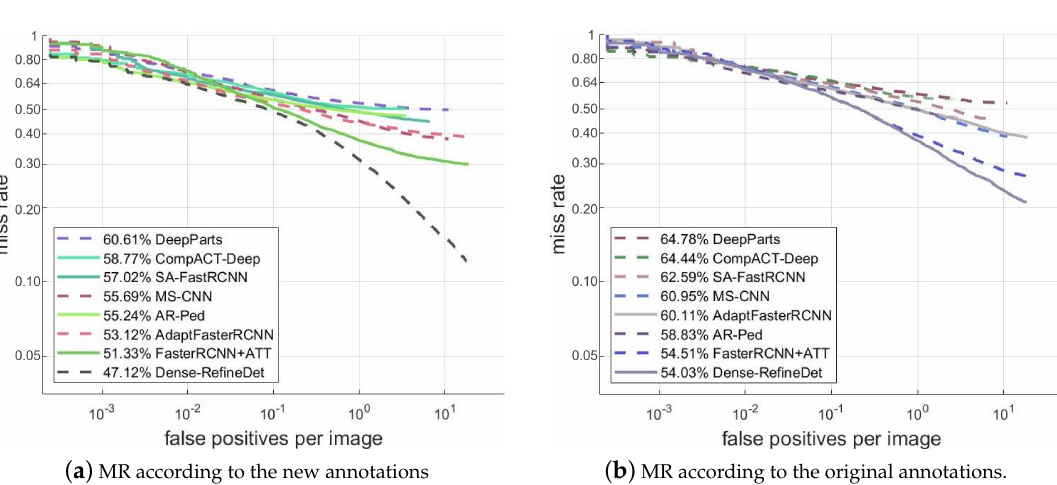
Figure 6. Comparisons of detection results on the Caltech pedestrian dataset. ( a ) MR according to the new annotations, ( b ) MR according to the original